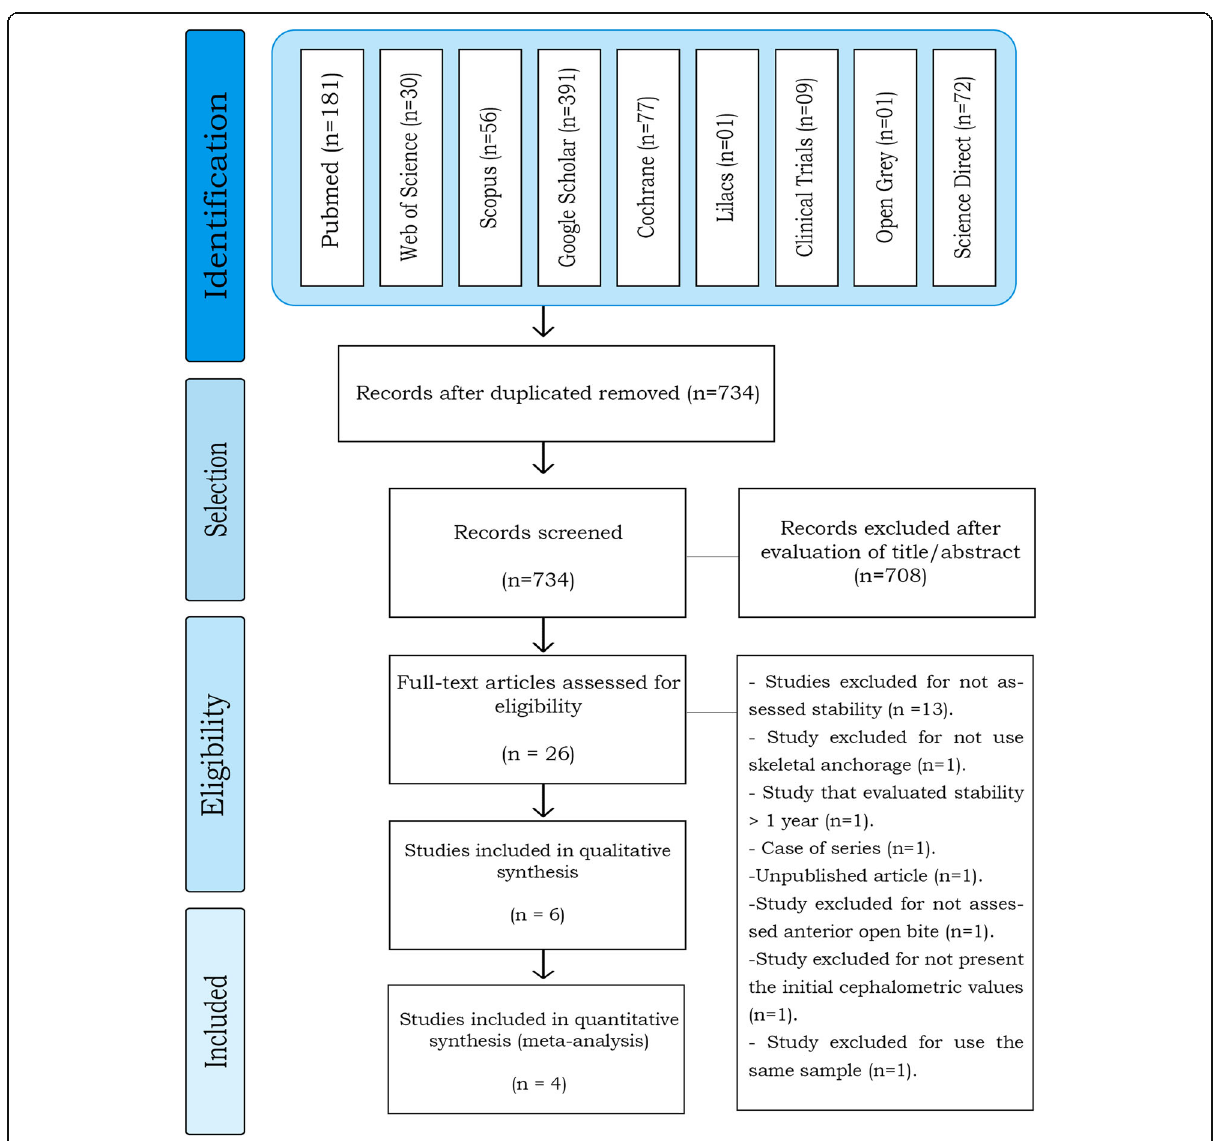
Fig. 1 Flow diagram of literature search and selection criteria. Adapted for